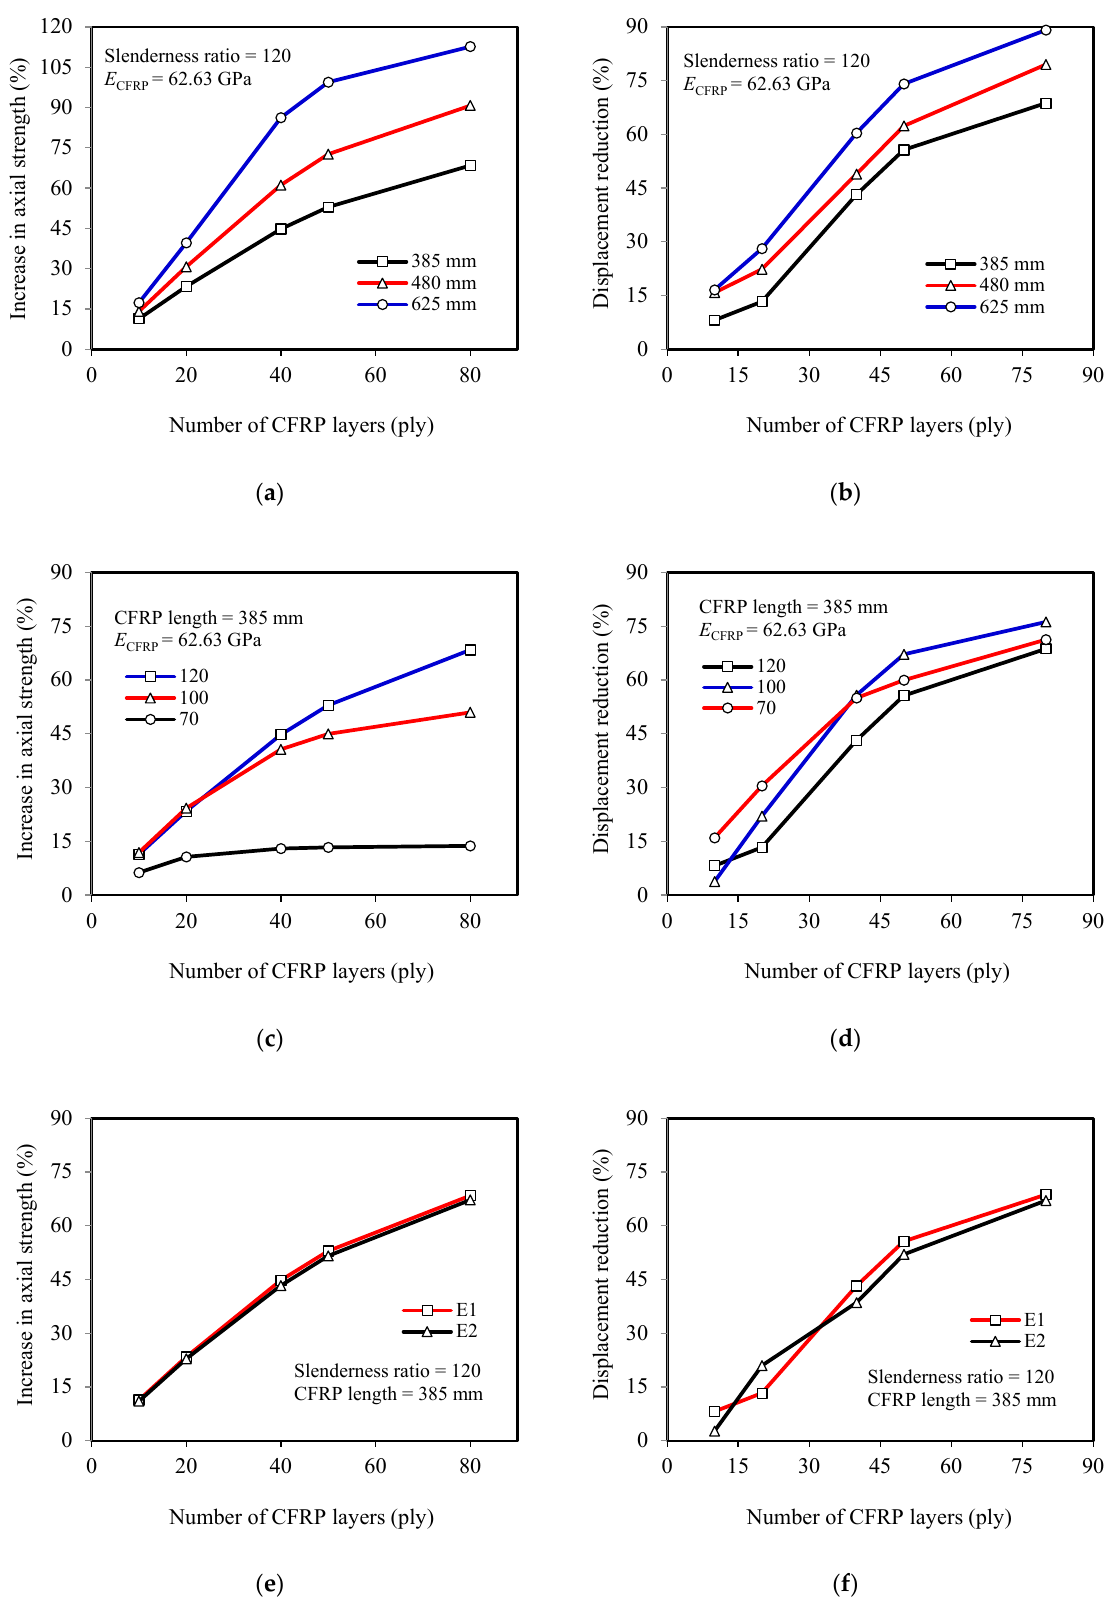
Figure 12. Parametric study results: ( a ), ( c ), and ( e ) Effect of CFRP length, steel’s slenderness ratio, and CFRP’s elastic modulus respectively on strength increase; ( b ), ( d ), and ( f ) Effect of CFRP length, steel’s slenderness ratio, and CFRP’s elastic modulus respectively on displacement reduction.